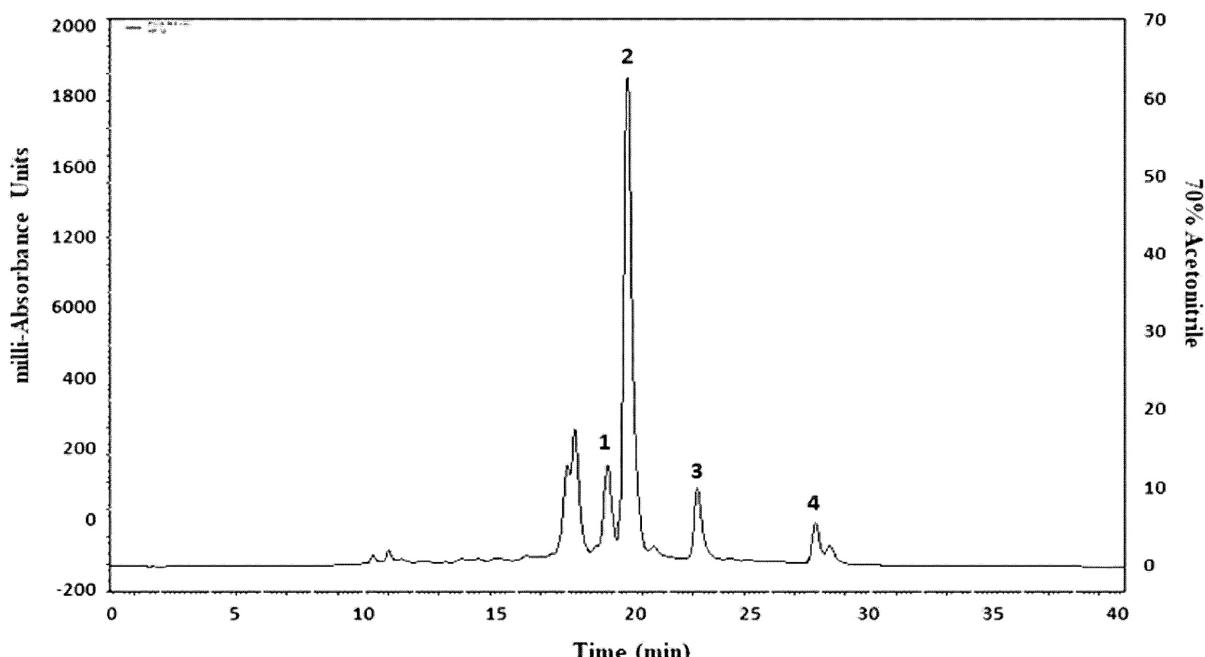
Fig 6. Representative HPLC profile of HWHF. Crude HWHF was chromatographed with flow rate of 1.0 ml/min on a (10 x 250 mm) semi- preparative 5 μ m C-18 column (Phenomenex, UK). The concentration of the eluting solvent was raised using linear gradients of acetonitrile (0–20% from 0 to 10 min, 20–70% from 10 to 40 min and 70–20% from 40 to 60 min). Compounds were detected by measurement of absorbance at 254- 360nm.